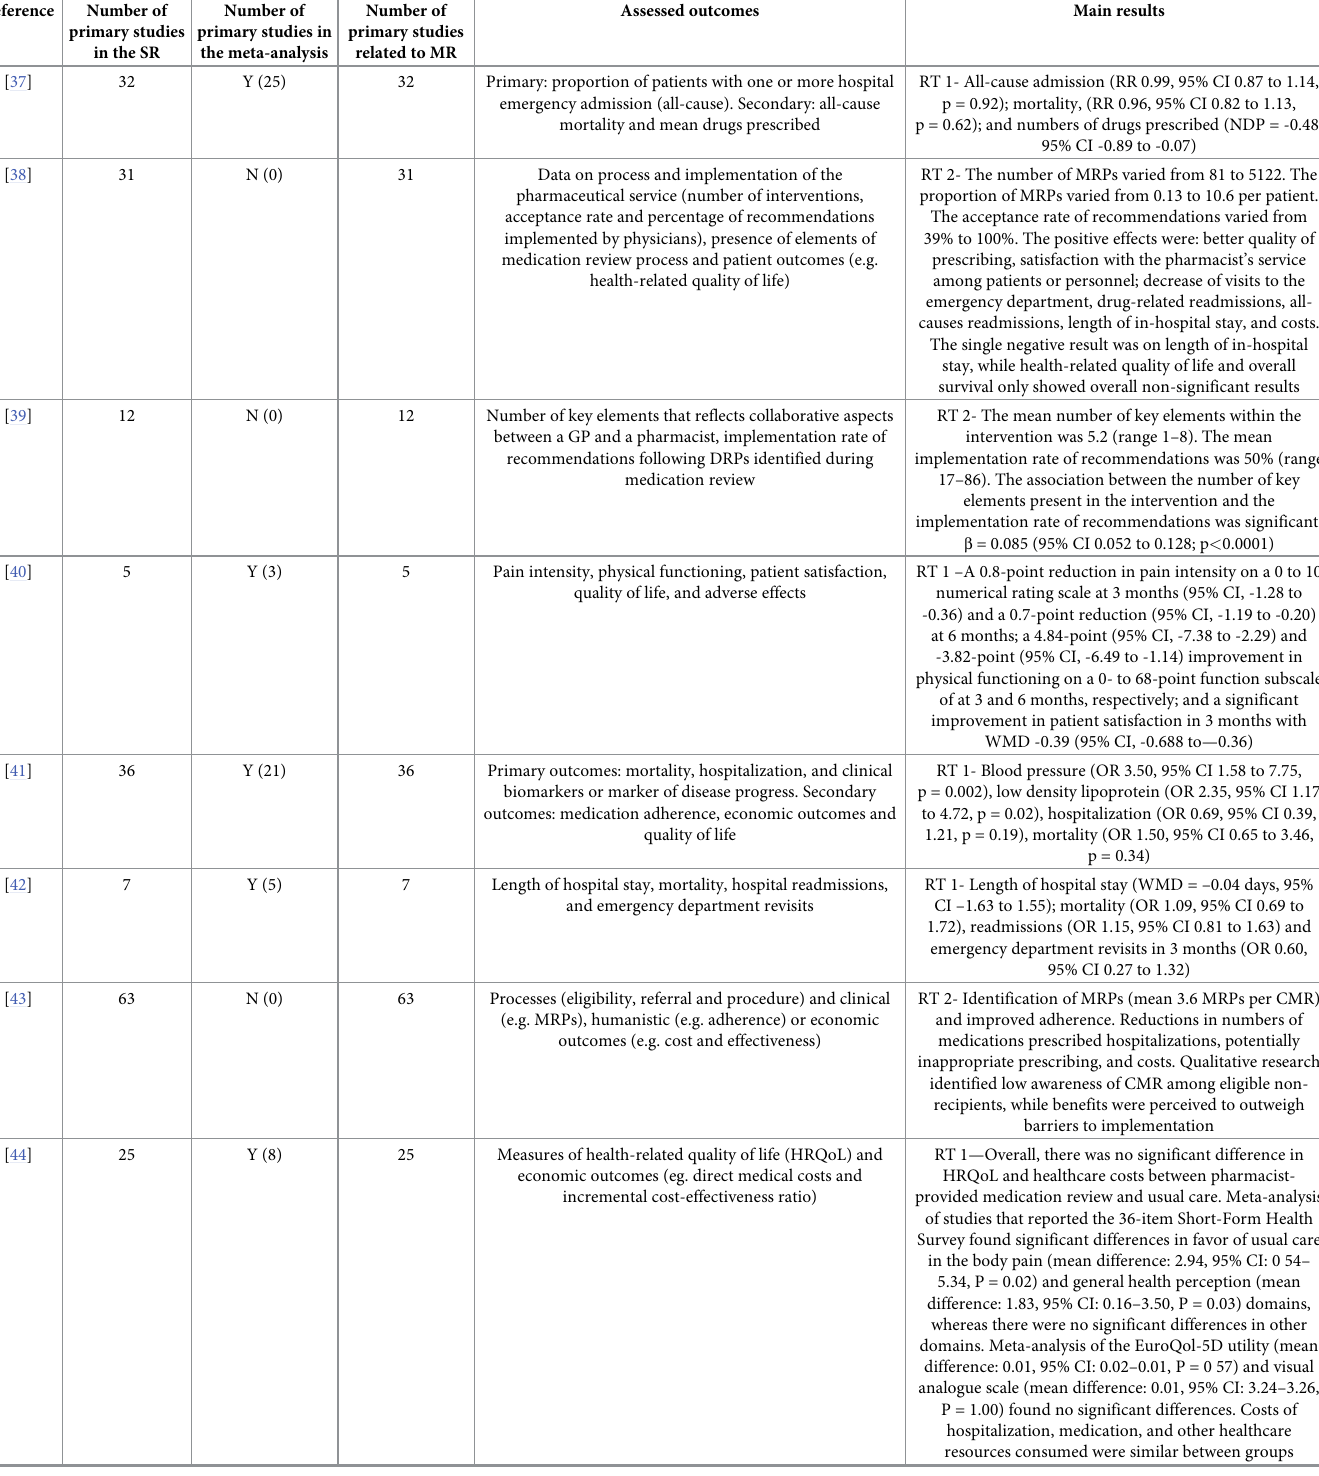
Table 2. Number of primary studies in the systematic reviews, meta-analysis, and related to MR; assessed outcomes, main results; and structure, processes and out- comes